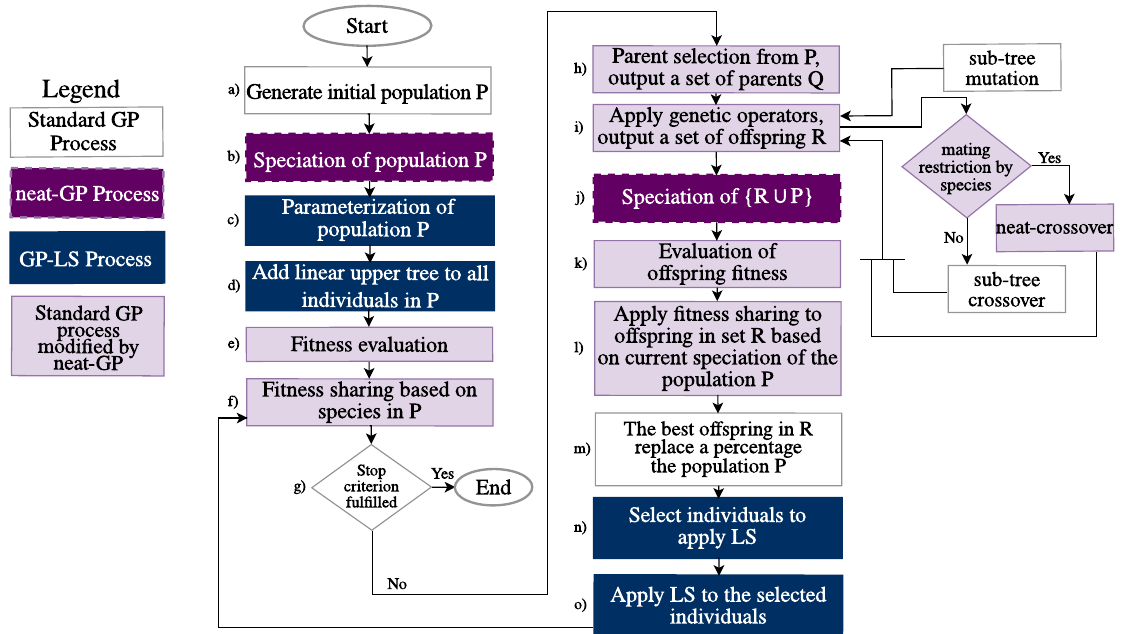
Figure 3. General flow diagram of the neat-GP-LS algorithm ([2], with permission from